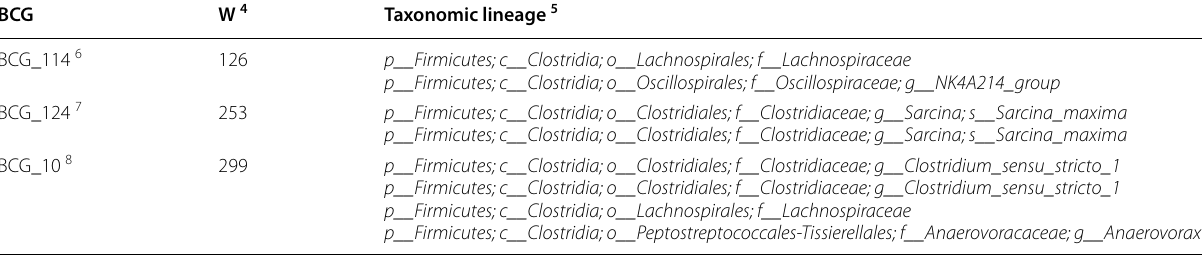
Table 4 Differentially abundant 1 bacterial co‑abundance groups (BCG) 2 and ungrouped amplicon sequence variants (ASV)